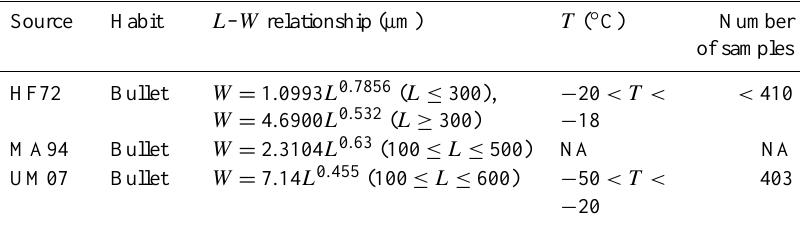
Table 3. Summary of L – W relationships of bullet crystals from previous studies: HF72 (Heymsfield, 1972), MA94 (Mitchell and Arnott, 1994), and UM07 (Um and McFarquhar, 2007). NA indicates that corresponding information is not available.